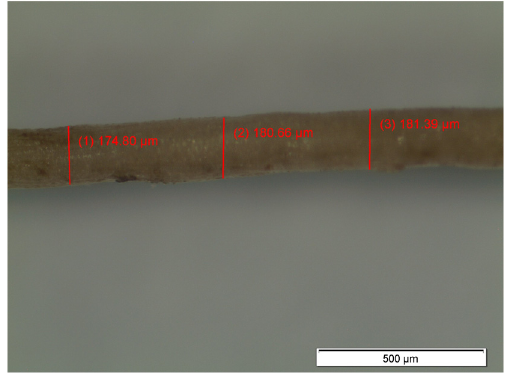
Figure 3. Optical microscope image of a coir fiber.